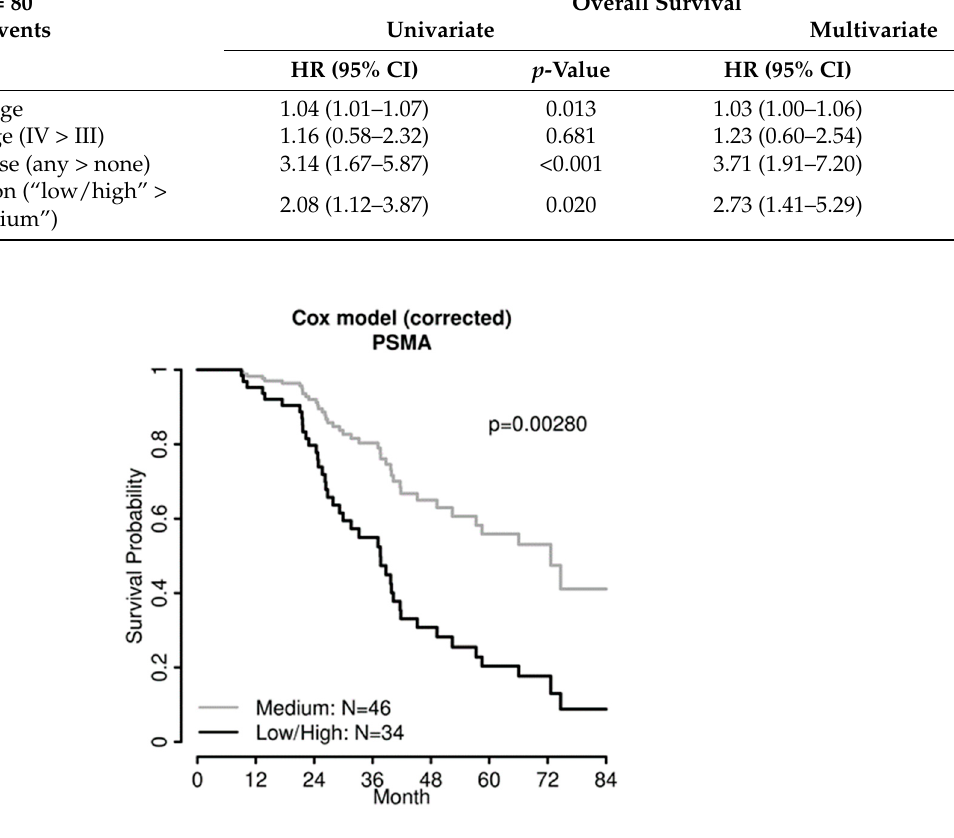
Figure 3. In multivariate analysis, PSMA expression was an independent marker for overall survival in 80 patients with advanced high-grade ovarian cancer, comparing two groups with “low/high” and “medium” PSMA expression. As these survival curves represent a multiple Cox regression model, no censored patients are indicated. Table 3. Overall survival, univariate, and multivariate analyses.